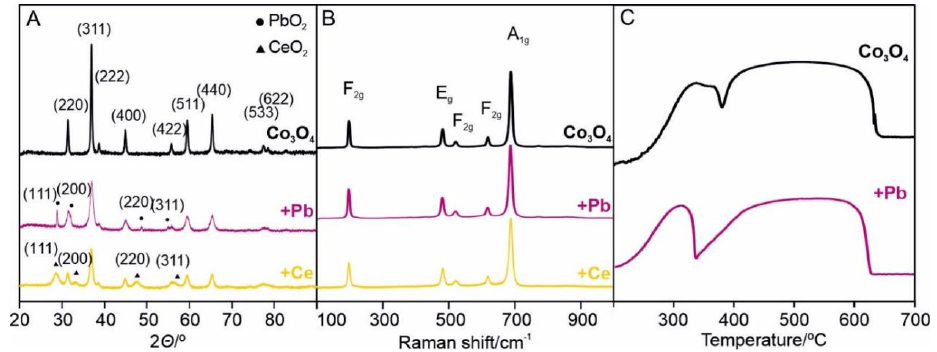
Figure 7. Physicochemical characterization of Pb- and Ce-doped Co 3 O 4 based catalysts by XRD ( A ), Raman Spectroscopy ( B ) and TPR ( C ) techniques.